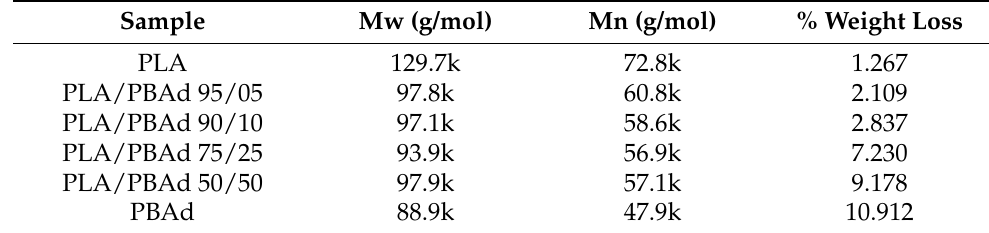
Table 2. SEC estimated molecular weight values, M w and M n , and % weight loss, after six days of enzymatic